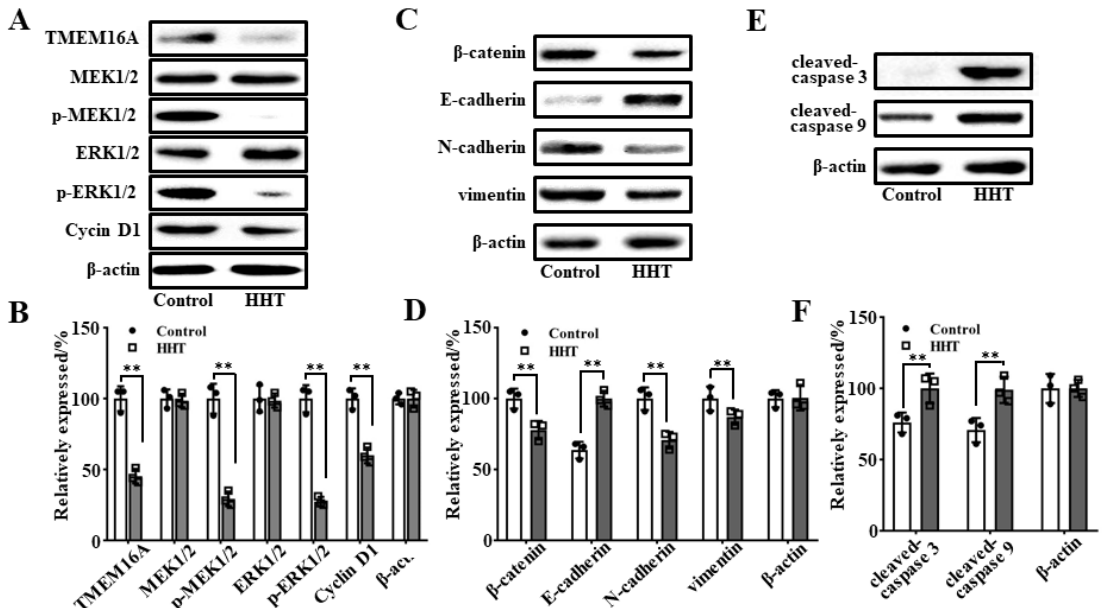
Figure 8. The molecular mechanism of HHT inhibited tumor growth. ( A ) Expression of TMEM16A, MEK1/2, phospho-MEK1/2, ERK1/2, phospho-ERK1/2, and cyclin D1 in 50 μΜ HHT incubated LA795 cells ( n = 3). ( B ) Statistical results of ( A ) ( n = 3, ** P ＜ 0.01). ( C ) Expression of β -catenin, E-cadherin, N-cadherin, and vimentin in 50 μΜ HHT incubated LA795 cells ( n = 3). ( D ) Statistical results of ( C ) ( n = 3). ( D ) Expression of cleaved-caspase 3 and cleaved-caspase 9 in 50 μΜ HHT incubated LA795 cells ( n = 3, ** P ＜ 0.01). ( E ) Statistical results of ( D ) ( n = 3, ** P ＜ 0.01).